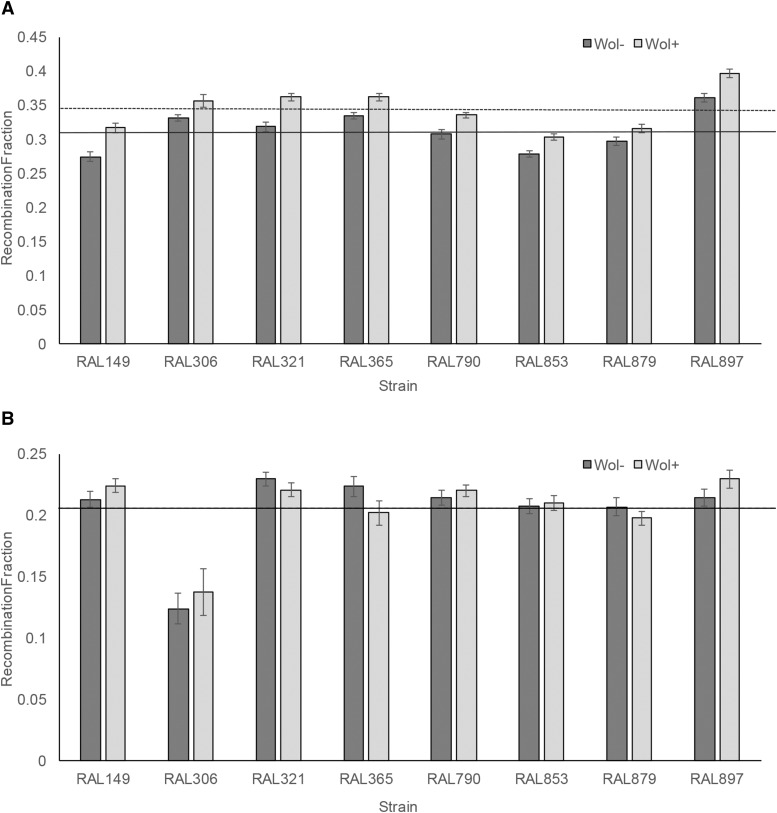
Mean recombination fraction between a) yellow and vermillion and b) ebony and rough interval as a function of genetic background and Wolbachia infection status. Dark gray bars are Wolbachia-free lines and the light gray bars are the Wolbachia-infected counterparts. Error bars denote standard error. Average recombination rate (across lines) is depicted for Wolbachia-infected (dashed line) and uninfected lines (solid line) though they are not both visible in panel b because they are so close together (0.204(uninfected) vs. 0.205(infected)).